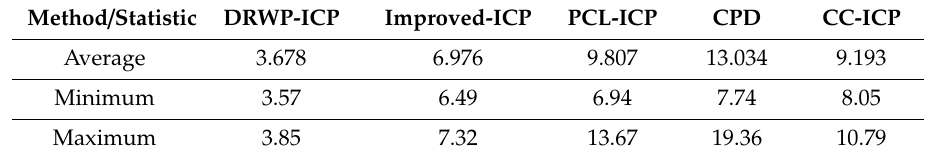
Table 14. RMS errors of five reference points under all sparse, noisy, and outlier conditions